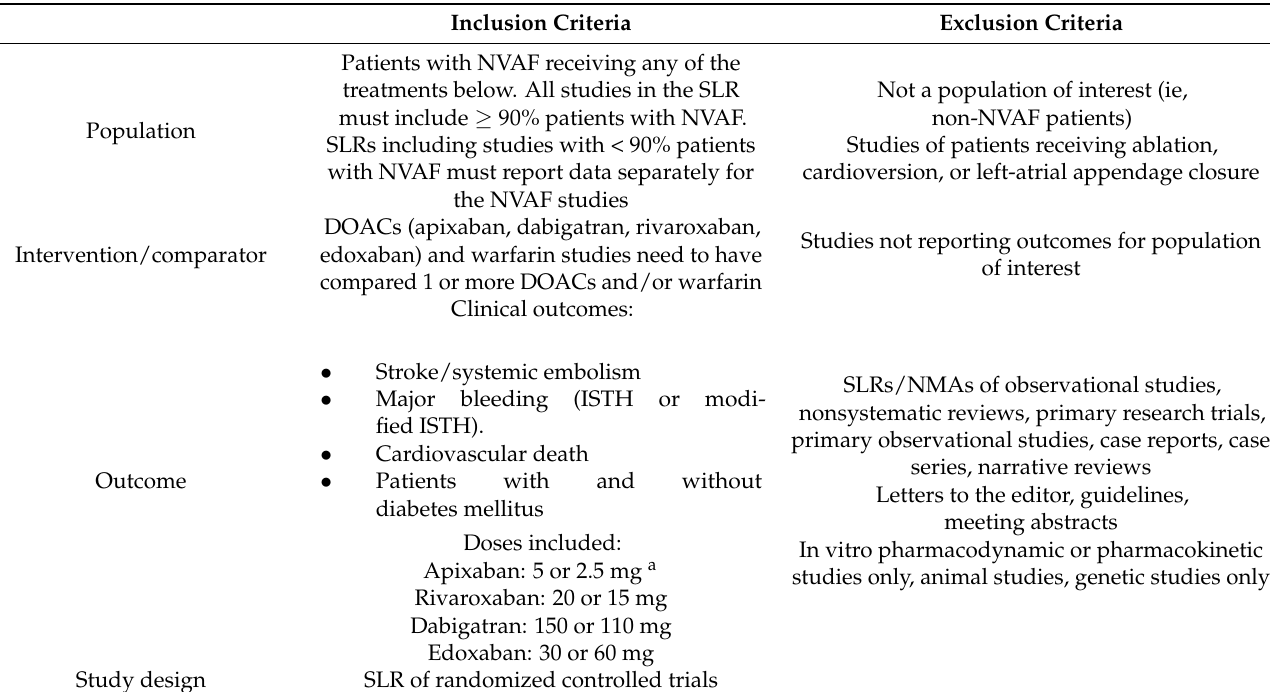
Table 1. PICOS criteria for inclusion and exclusion of systematic